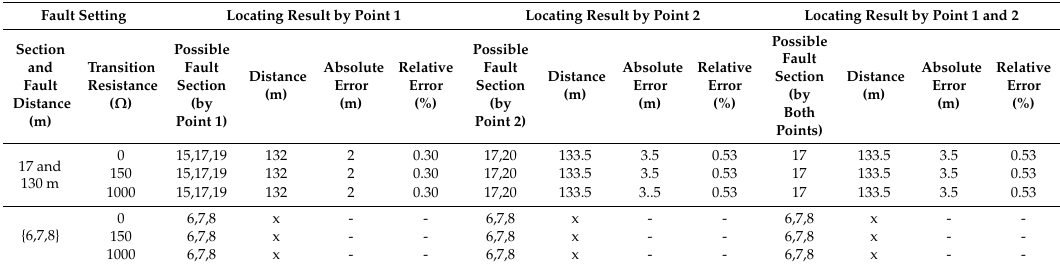
Table 7. Simulation results under di ff erent transition resistances.